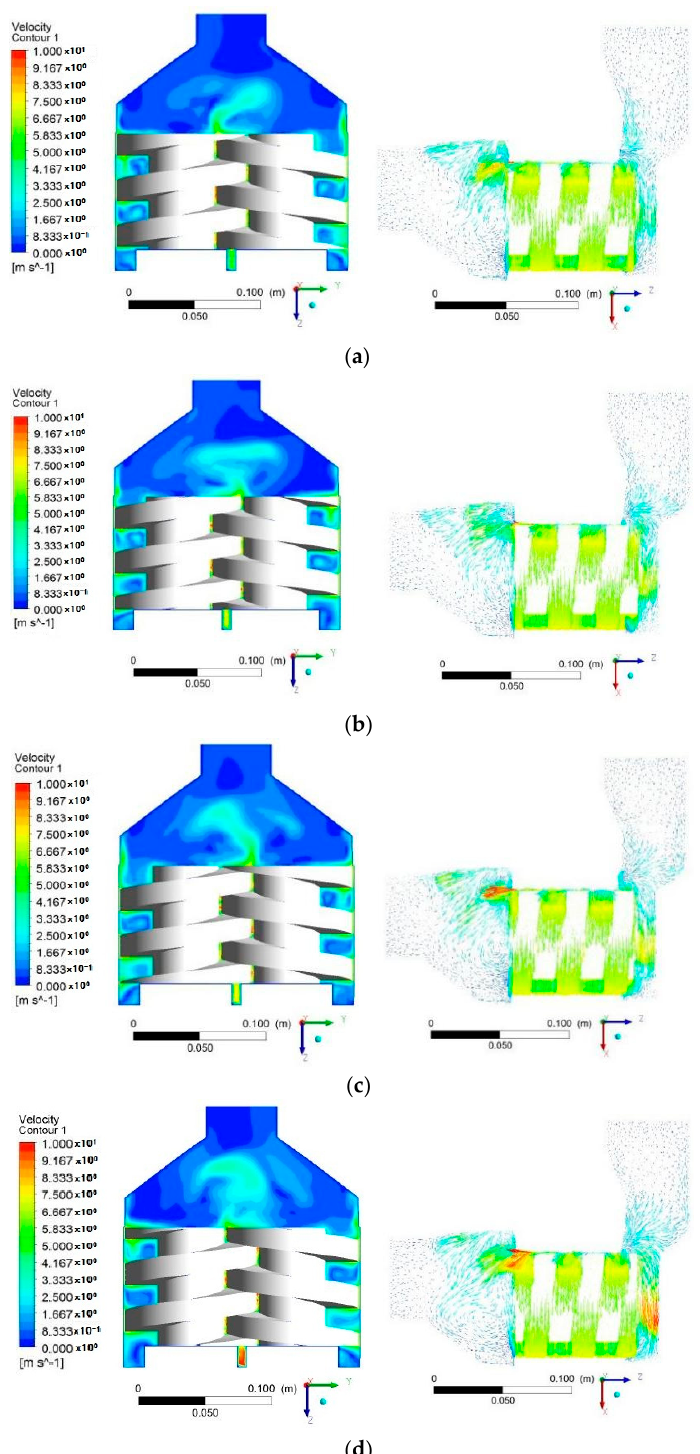
Figure 15. Local velocity distribution. ( a ) 1 / 4T cycle velocity distribution; ( b ) 1 / 2T cycle velocity distribution; ( c ) 3 / 4T cycle velocity distribution; ( d ) 1T cycle velocity distribution.